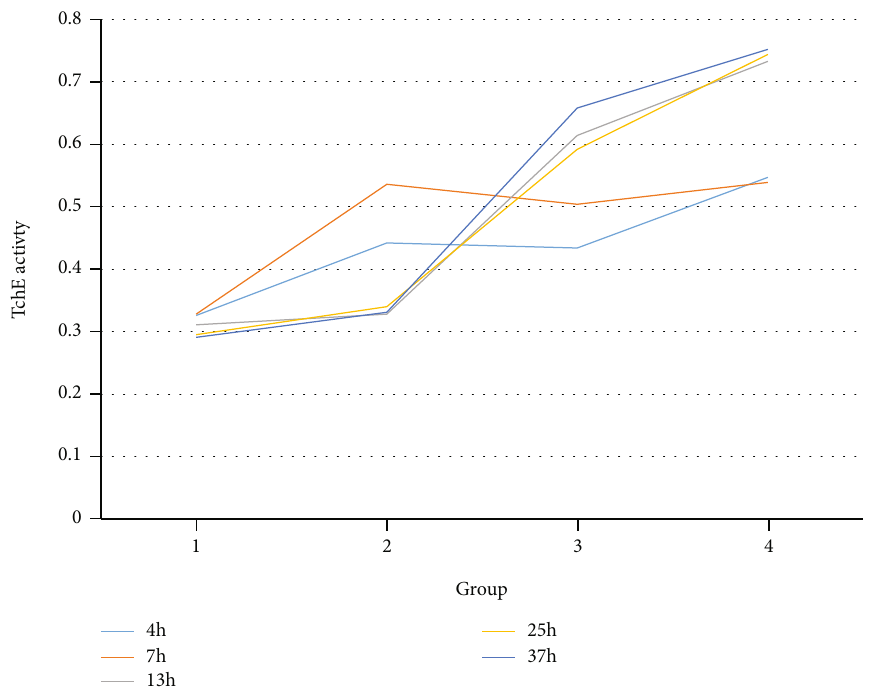
Figure 3: After administration TchE activity in all groups.